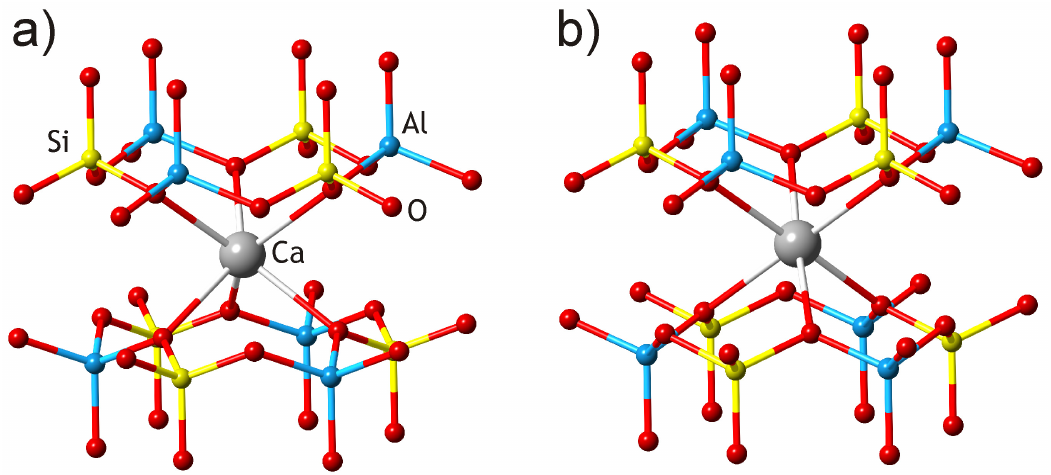
Figure 5. Two possible coordination environments of the Ca site in dmisteinbergite: trigonal prismatic ( a ) and trigonal antiprismatic ( b ) (distorted octahedral).